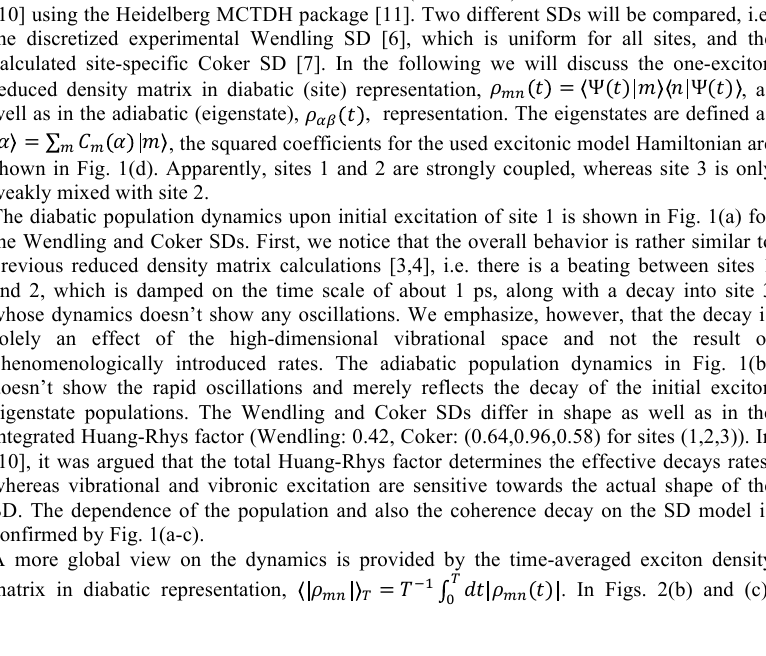
Fig. 1 . Population dynamics using the Wendling and Coker SDs ((a) diabatic basis, (b) adiabatic basis, decomposition of adiabatic into diabatic states is given in panel (d)). Panel (c) shows the coherence evolution between adiabatic states 2 and 3 (corresponding to an off-diagonal peak in the 2D spectra) for both SDs. Numbers in circles label the respective states.